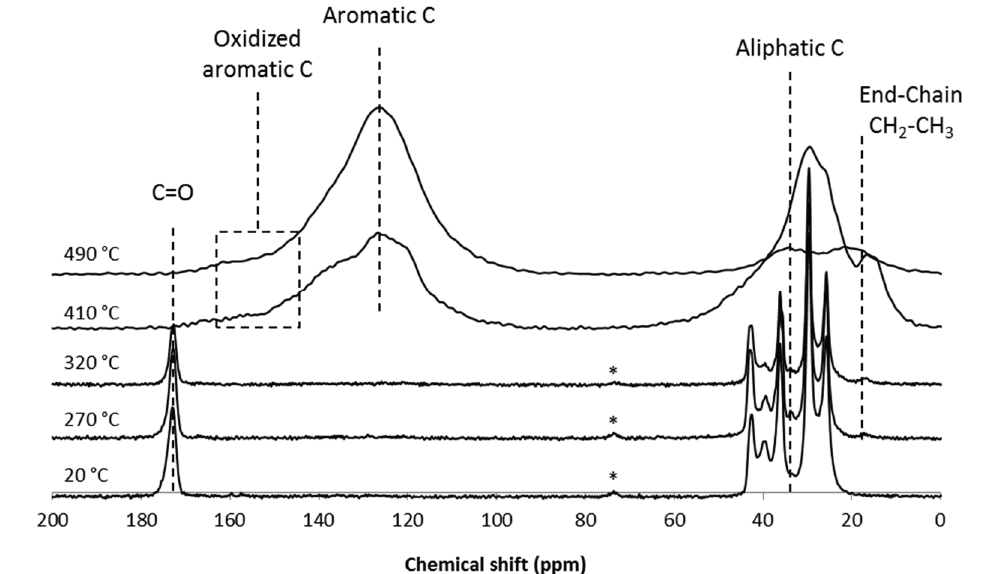
Figure 7. 13 C CP-DD-MAS NMR spectra of the PA6/GAS 2.5%/MPP2.5% residues obtained after thermal treatment at 20, 270, 320, 410 and 490 °C (* spinning sideband).